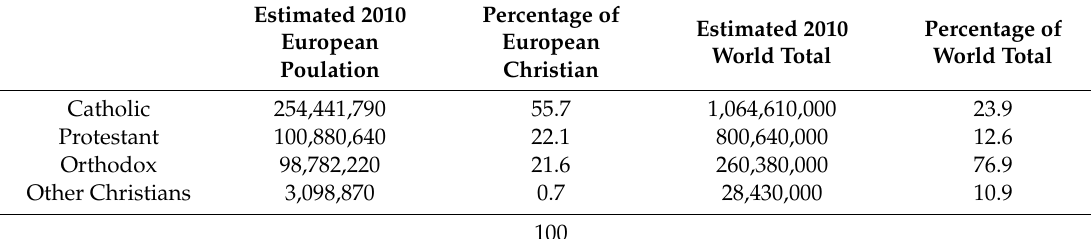
Table 8. Christian traditions in Europe and in the world